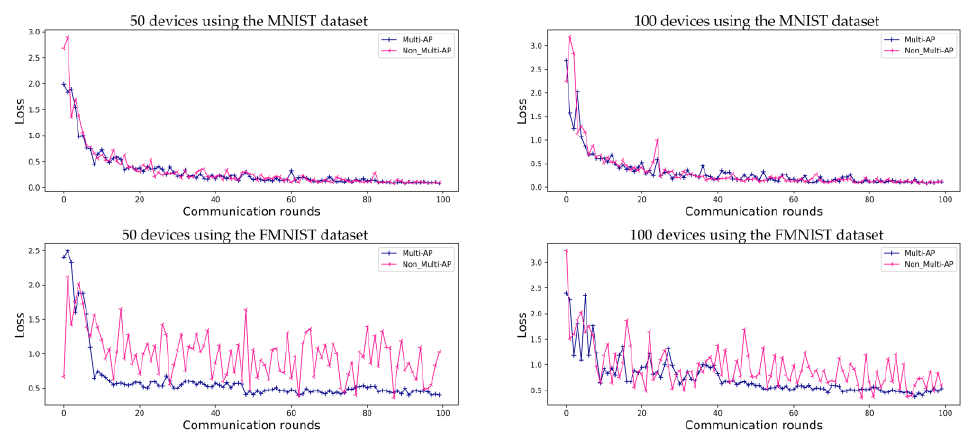
Figure 5. Evaluation of loss of prediction for FL using the MNIST and FMNIST datasets in environ- ments with five APs, for 100 communication rounds. Both the proposed ‘Multi - AP’ and ‘Non_Multi - AP’ models converge when using the MNIST datasets, while the ‘Non_Multi - AP’ model does not converge when the FMNIST dataset is used.